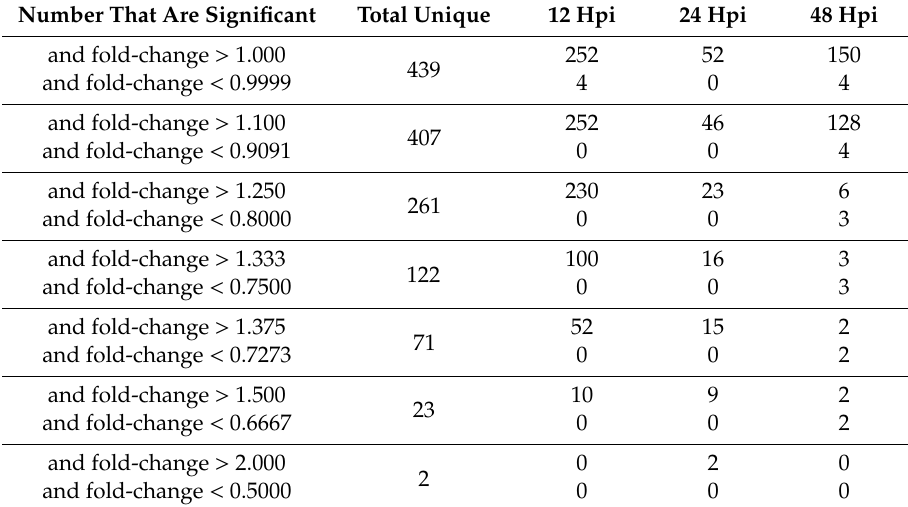
Table 1. Numbers of significantly dysregulated ZIKV-infected CaCo-2 proteins.